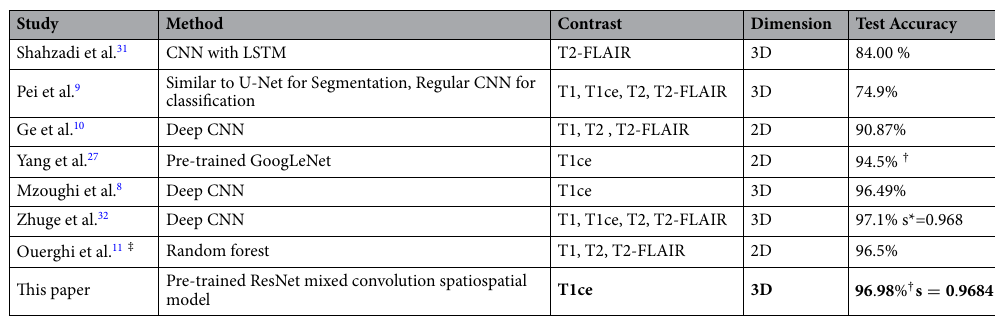
Table 6. Comparisons against other published works *s=specificity † cross-validated ‡ State of the